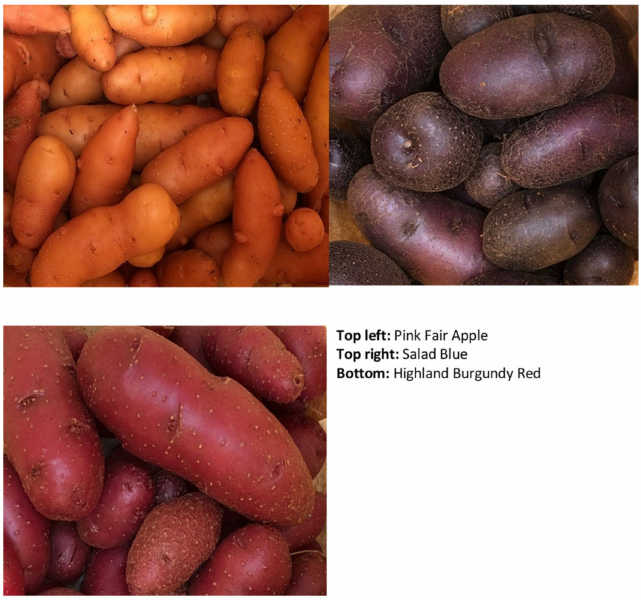
Figure 4. Some pigmented cultivars from South